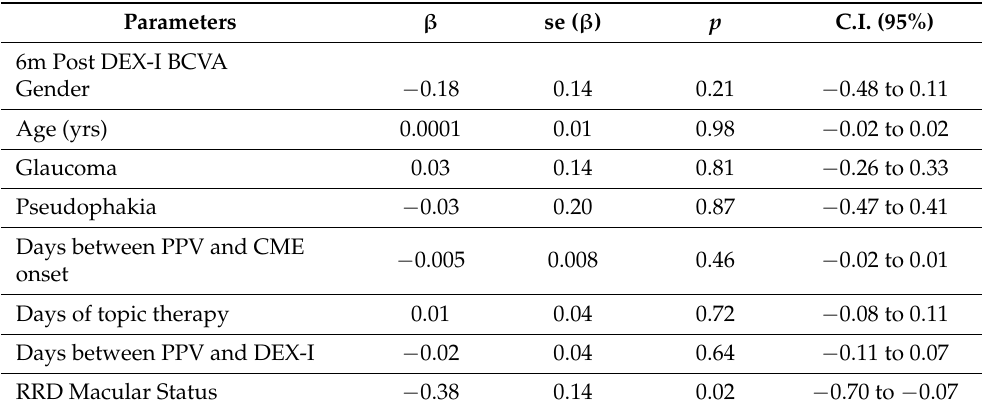
Table 4. Multiple linear regression model of BCVA at 6 months after DEX-I and all variables together in the